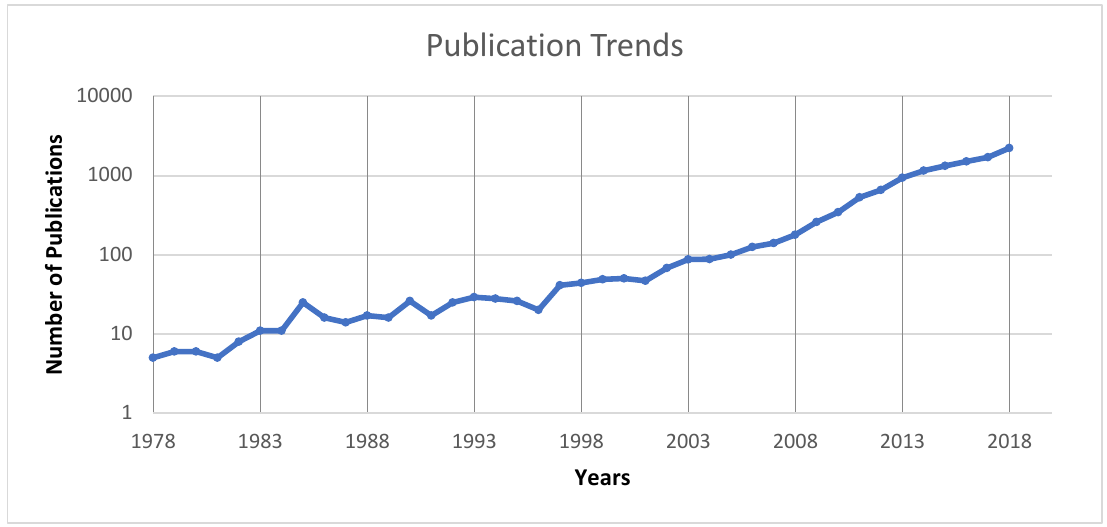
Figure 4. The trend of publications in social networks, health, and young people during the period of 1978 – 2018.